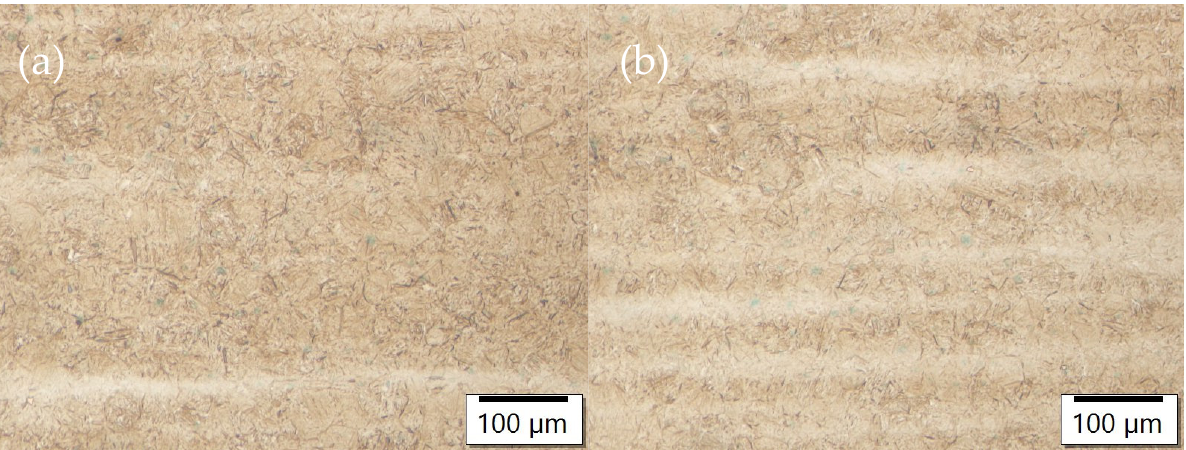
Figure 8. The microstructures of quenched sample 1040 ◦ C-30 min, etched with Nital. ( a ) Area with less segregation bands, ( b ) area with more segregation bands.